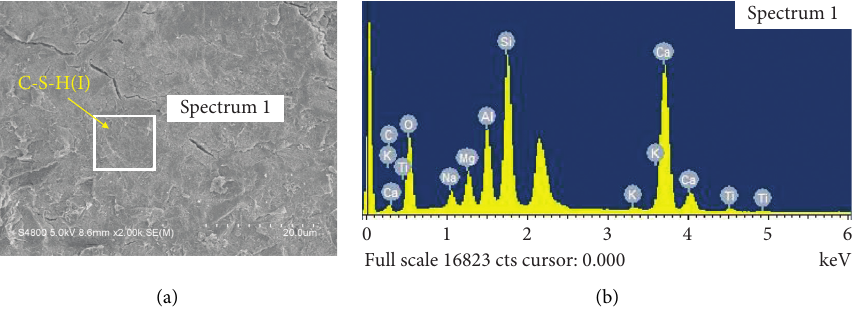
Figure 5: SEM/EDS photograph of the AASC.